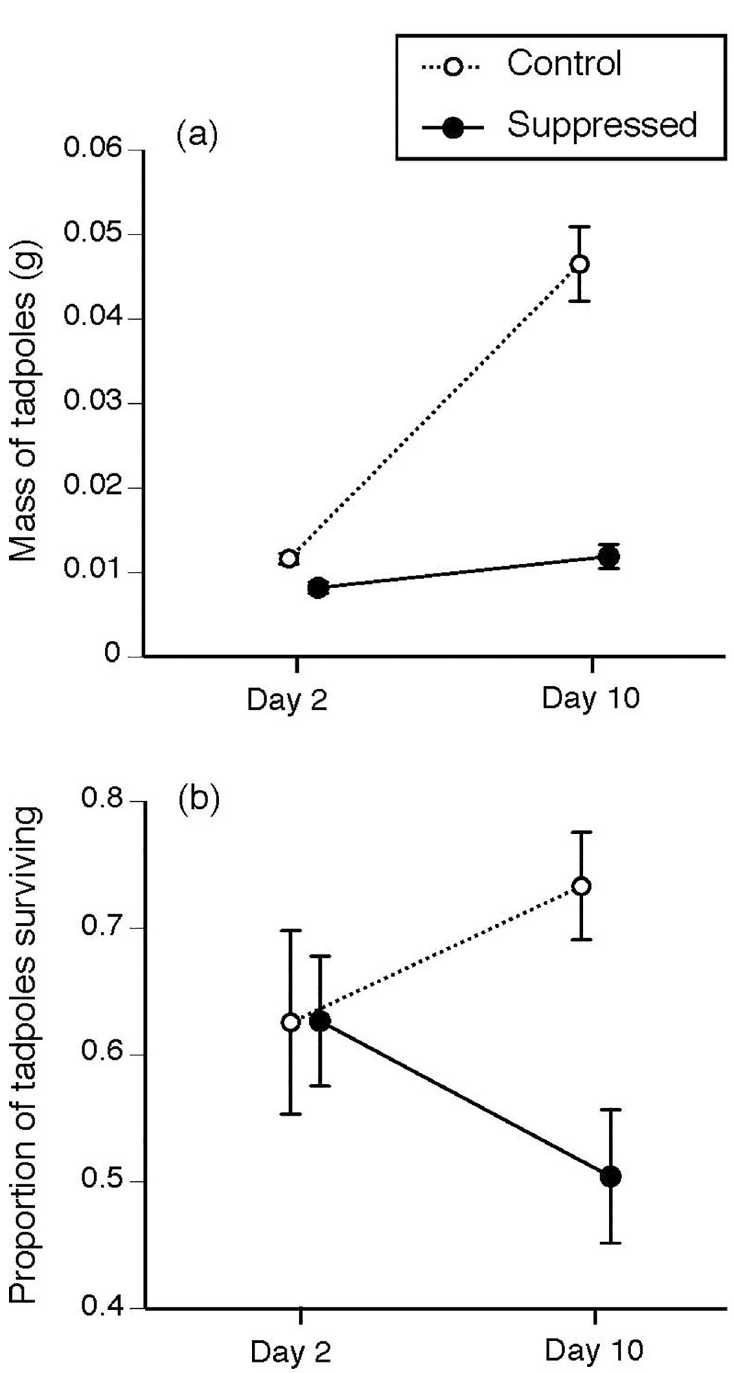
Fig 3. The (a) mass and (b) proportion of cane toad tadpoles ( Rhinella marina ) surviving 24 h of predator exposure, after 2 and 10 days of growth (n = 20 and 24–27 respectively). White circles represent non-suppressed tadpoles, and black circles represent suppressed tadpoles (exposed to older conspecifics for 48 h during larval development). The graphs show mean values ± SE.